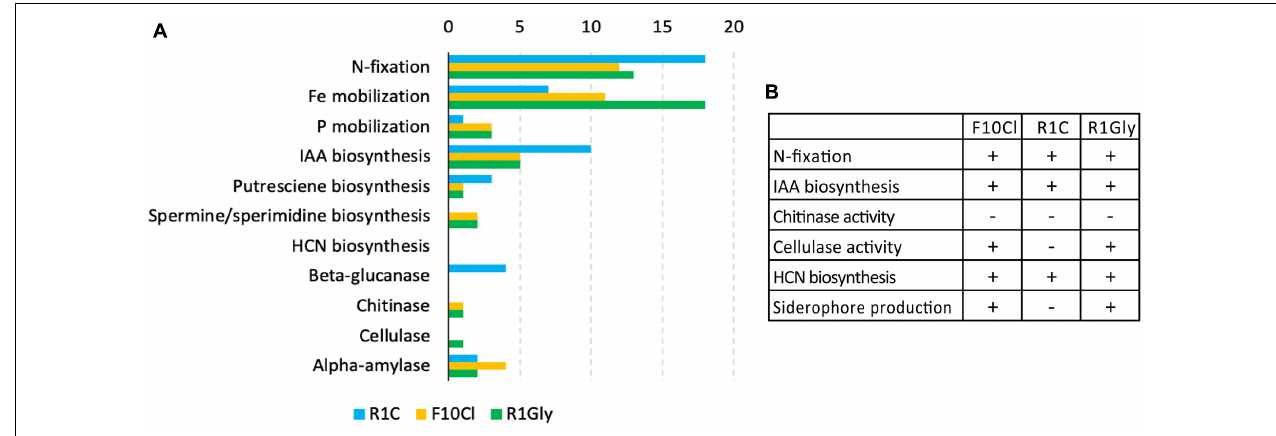
FIGURE 2 | (A) Numbers of genes associated with select PGP traits found in each isolate genome: R1C (blue), F10Cl (orange), and R1Gly (green). (B) Result summary for laboratory characterization assays. (+) indicates a positive result (activity observed) and (–) indicates a negative result (not